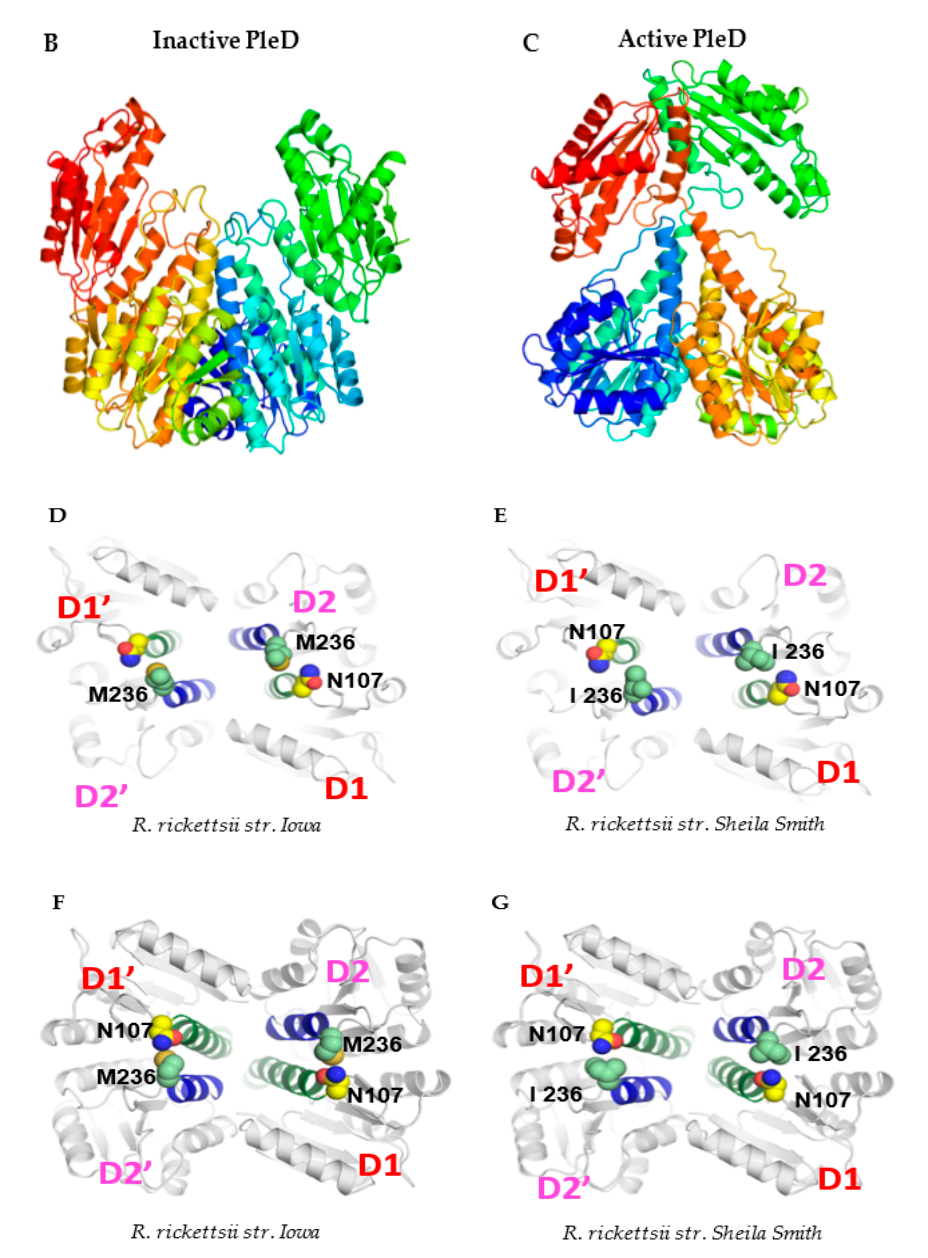
Figure 4. A single-nucleotide polymorphism (SNP) at position 708, with respect to the gene start site, in the pleD of R. rickettsii str. Sheila Smith and Iowa results in an amino-acid change at a key residue of the protein. ( A ) Nucleotide sequence and chromatograms of R. rickettsii str. Sheila Smith and Iowa showing SNP (red arrow) at position 708 with respect to the gene start site. Ribbon representation of the dimeric model structures (perpendicular to the two-fold axis of the stem) of the inactive ( B ) and active ( C ) PleD. In panels ( D – G ), the views of the PleD inactive and active dimeric models are rotated by 90° around a horizontal axis with respect to the top panels ( B , C ), and shown is the bottom view of the (D1/D2) dimer stem with the diguanylate cyclase (DGC) domain in the rear hide for clarity. The residue N107 (yellow) on receiver domain D1 and M236/I236 (light green) on adaptor domain D2 are highlighted. The α -helix5 on receiver domain and α -helix4 on adaptor domain are colored in green and blue,